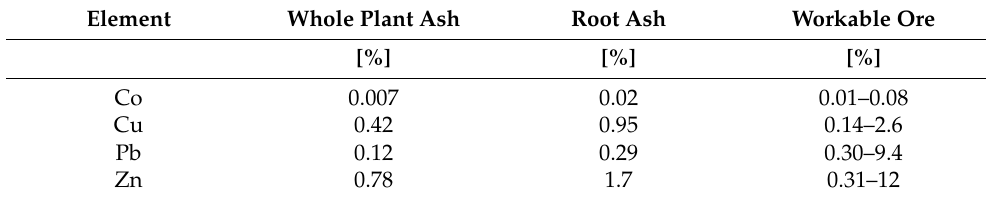
Table 4. Calculated indicative contents of Co, Cu, Pb, and Zn in ash after incineration of RF plants. For comparison, contents in workable ores are shown [45]. All amounts are given in %.